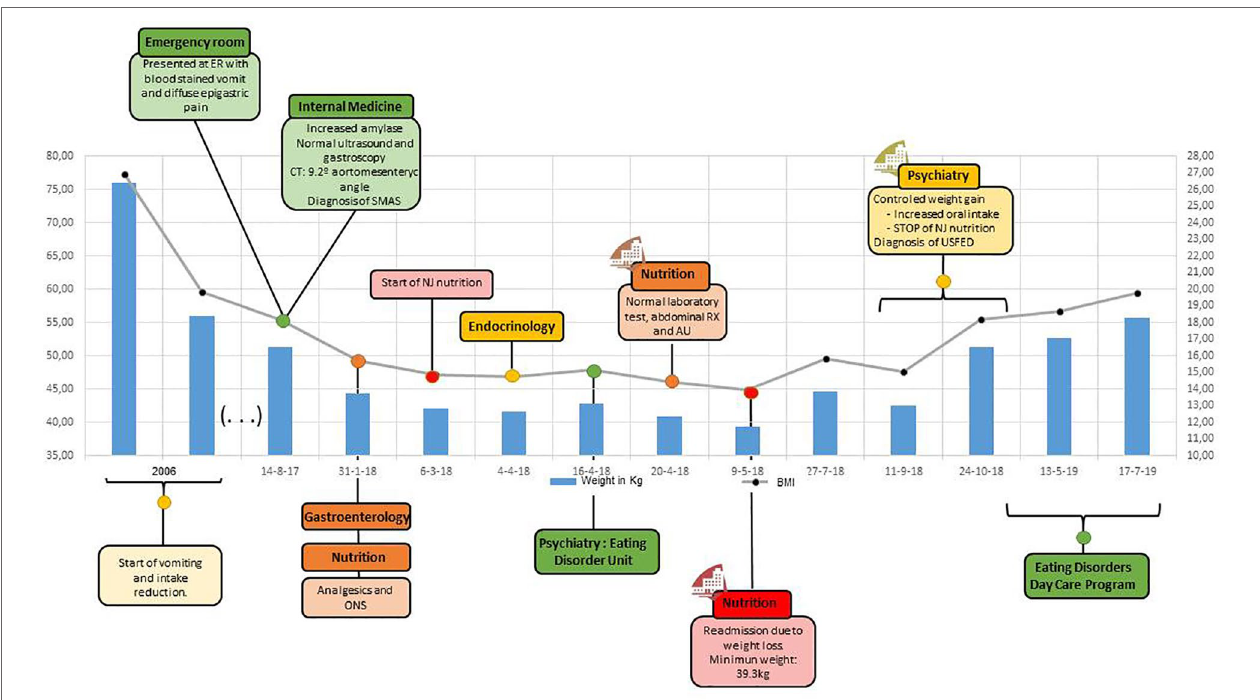
FIGURE 1 | Clinical case timeline.